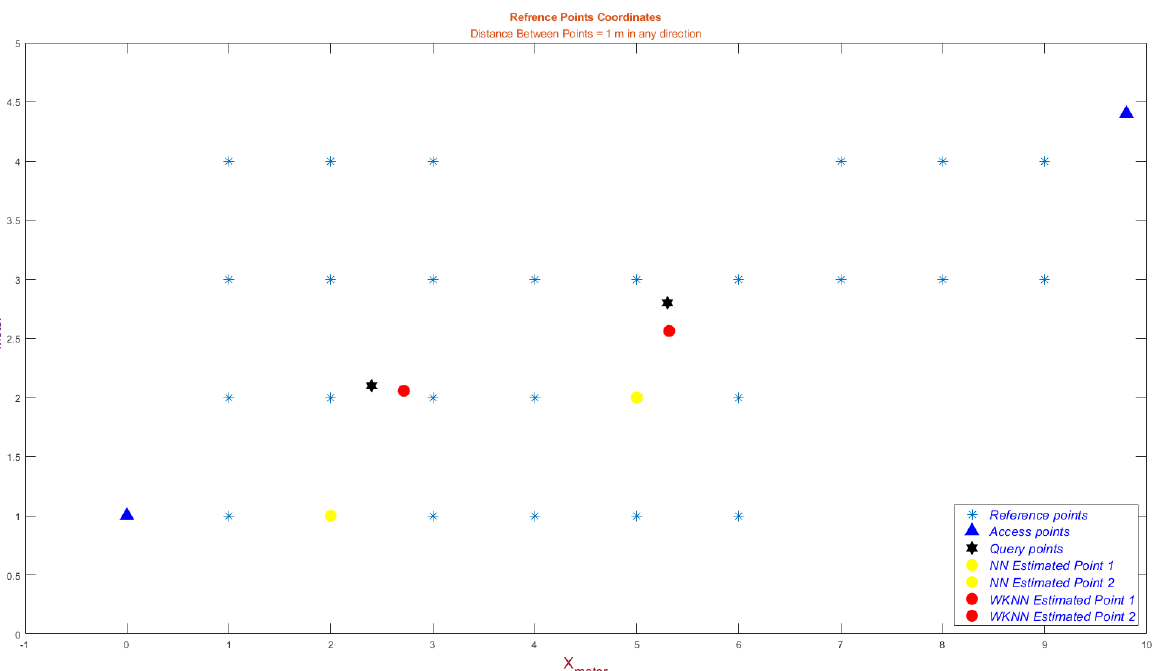
Figure 8 . A view of determining the position of the Target points by different methods (NN and WKNN) in the first Scenario (Blue stars are reference points, triangles are access points, black stars are target points, yellow circles are estimated points from NN method and red circles are estimated points from WKNN